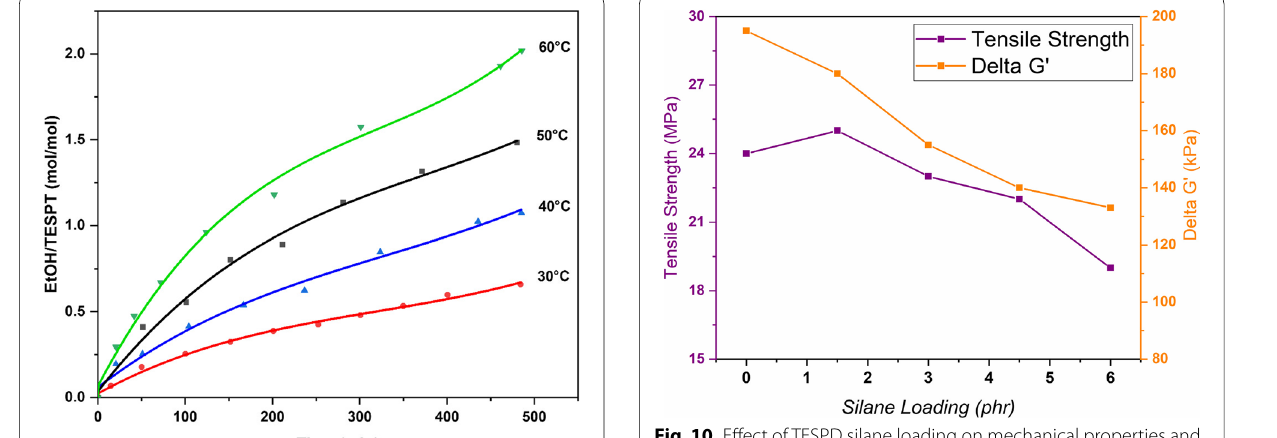
Fig. 10 Effect of TESPD silane loading on mechanical properties and filler‑polymer network of silica filled natural rubber composite [62]. Redrawn with permission from John Wiley and